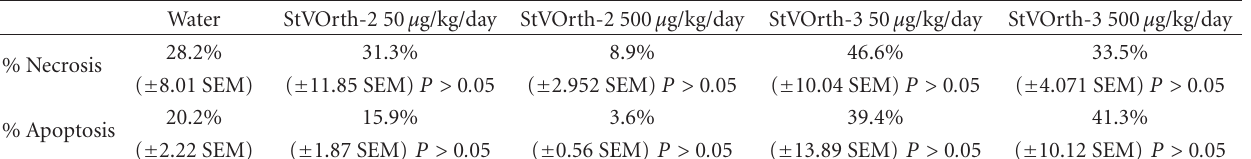
Table 1: Tumour per cent necrosis and apoptosis as determined on haematoxylin and eosin-stained and TUNEL-stained sections of orthotopic tumour, respectively.